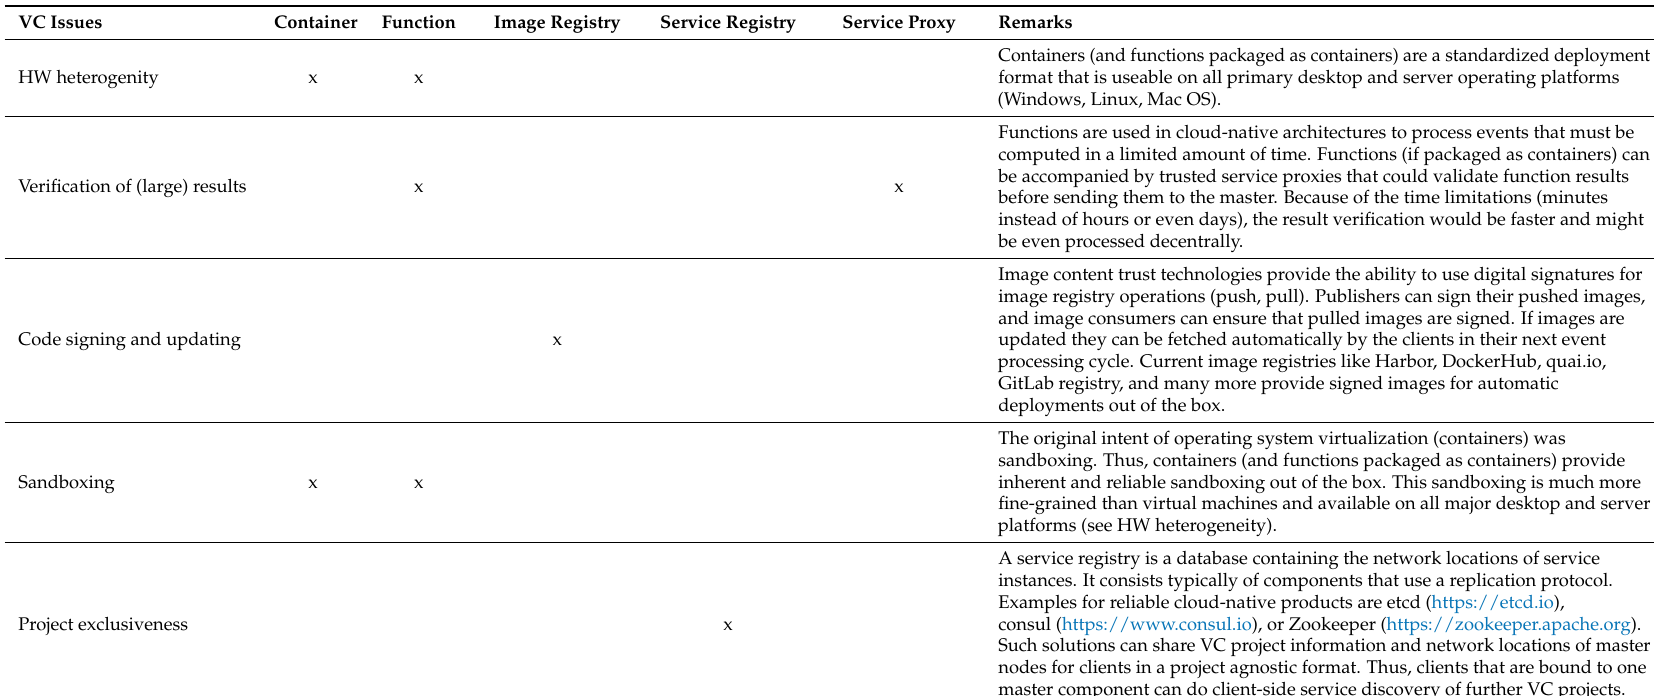
Table 2. Mapping of recent cloud-native technologies to identified VC open